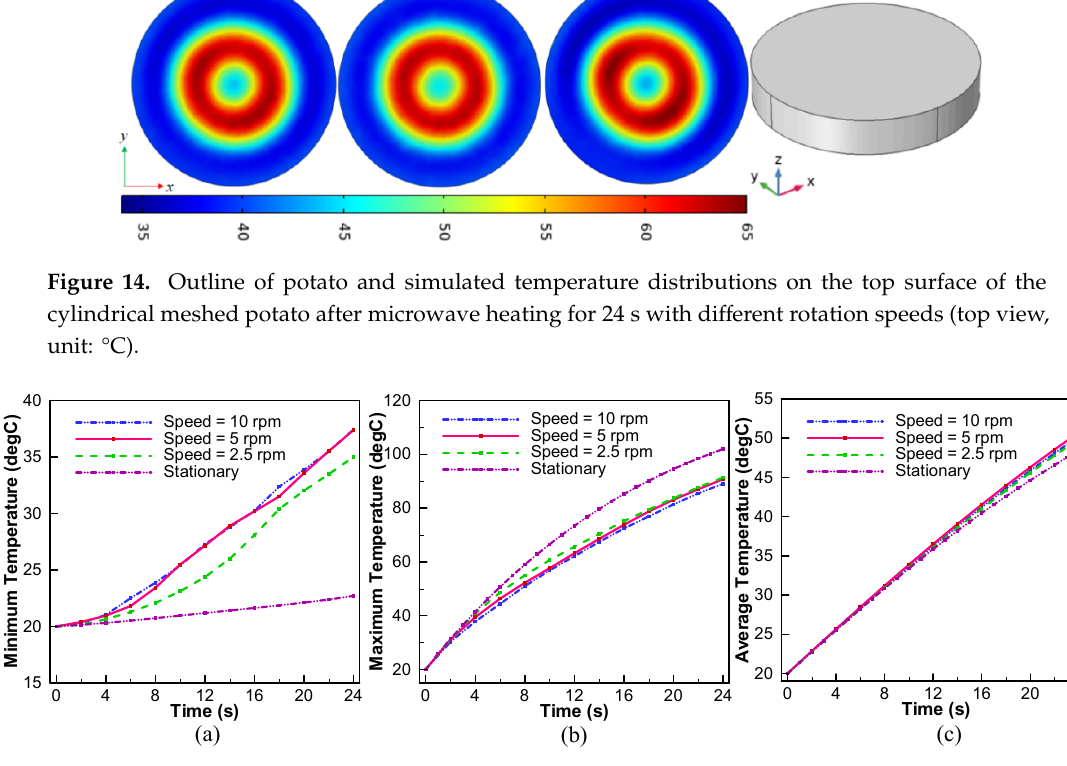
Figure 15. The minimum ( a ), maximum ( b ) and average ( c ) temperatures of the cylindrical shaped mashed potato heated with different speeds.